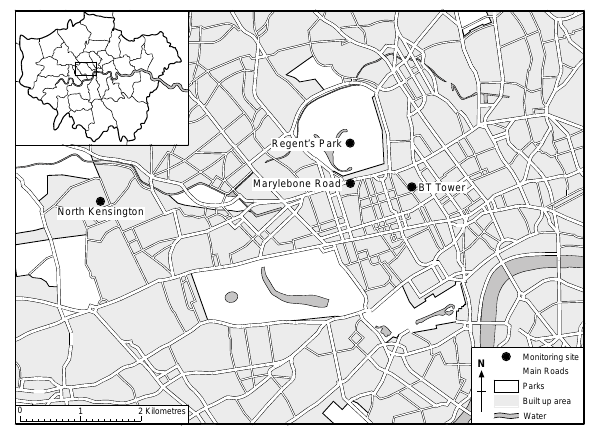
Fig. 1. Map showing sampling site locations. Inset map shows general location within central